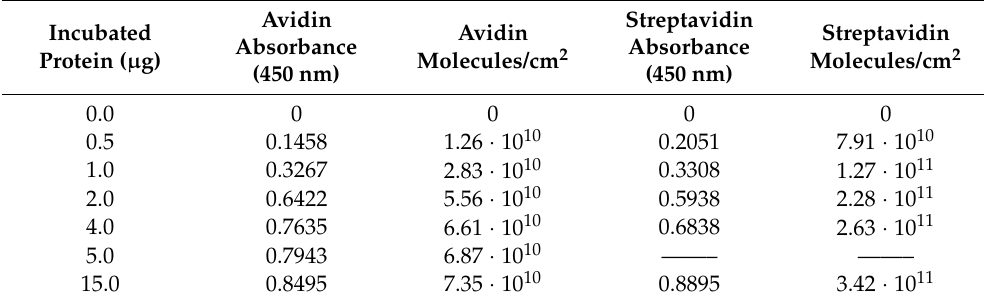
Table 2. Relationship between incubated micrograms of strept(avidin) with absorbances at 450 nm wavelength, and subsequently, immobilized strept(avidin) molecules per area unit of mica. Note that all strept(avidin) samples were diluted 10 times to not saturate the absorbance signal. Error is below 5%. Streptavidin Avidin Streptavidin Avidin Incubated Absorbance Absorbance Molecules/cm 2 Molecules/cm 2 Protein ( µ g) (450 nm) (450 nm)